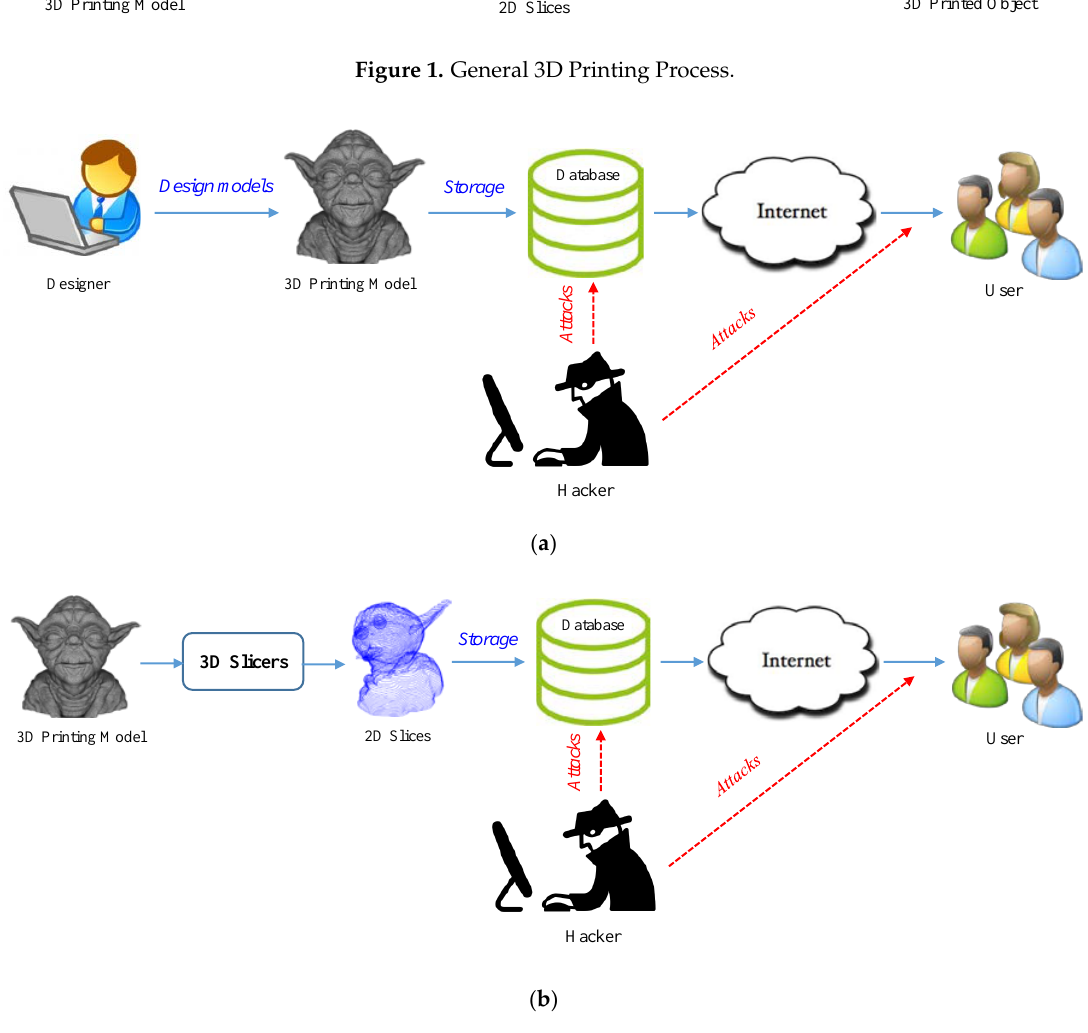
Figure 2. ( a ) Attack to three-dimensional (3D) printing model, and ( b ) attack to 3D printing data (two-dimensional (2D) Slice).